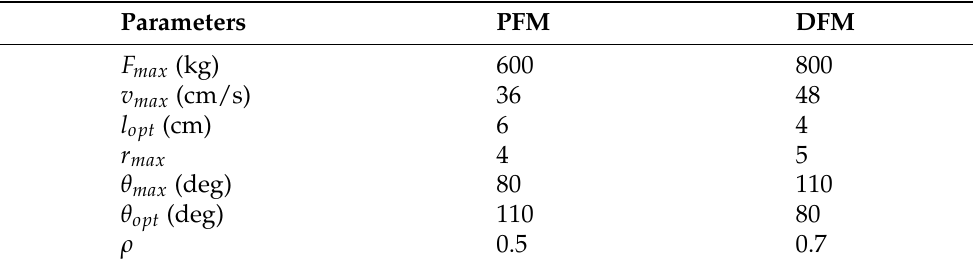
Table 2. The parameters of virtual muscle mechanical